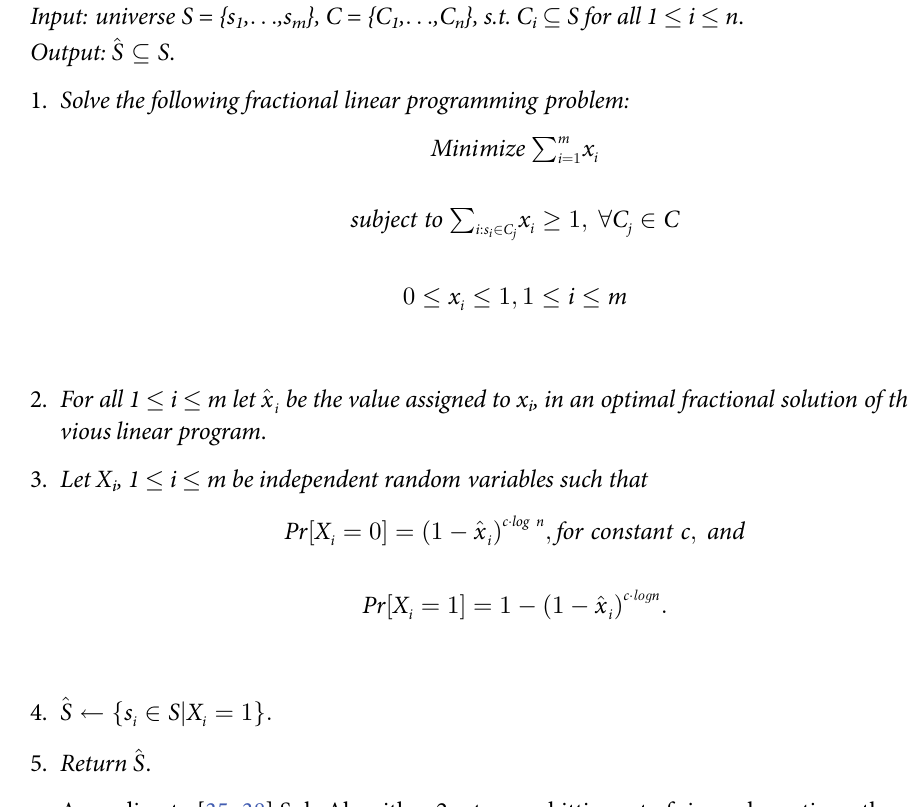
Sub Algorithm 2, linear programming randomized algorithm for